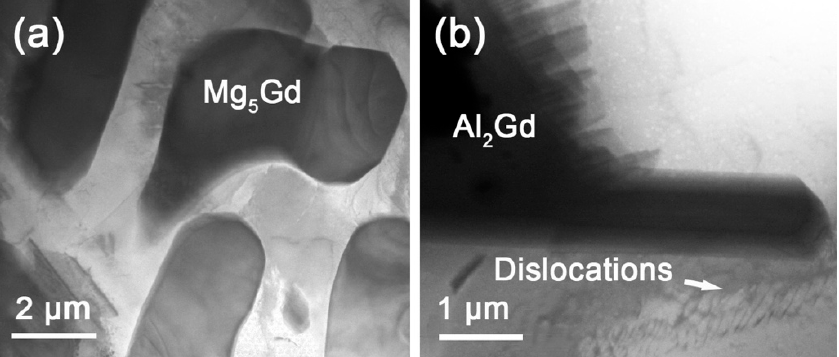
Figure 10. TEM images of the ( a ) Mg 5 Gd and ( b ) Al 2 Gd particles in the quenched Mg–Al–Gd alloys under 1 T.